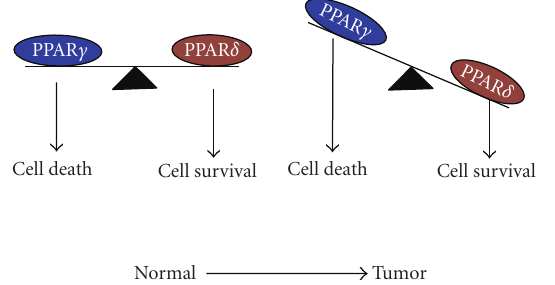
Figure 1: A potential model for PPARs regulating colorectal tumor